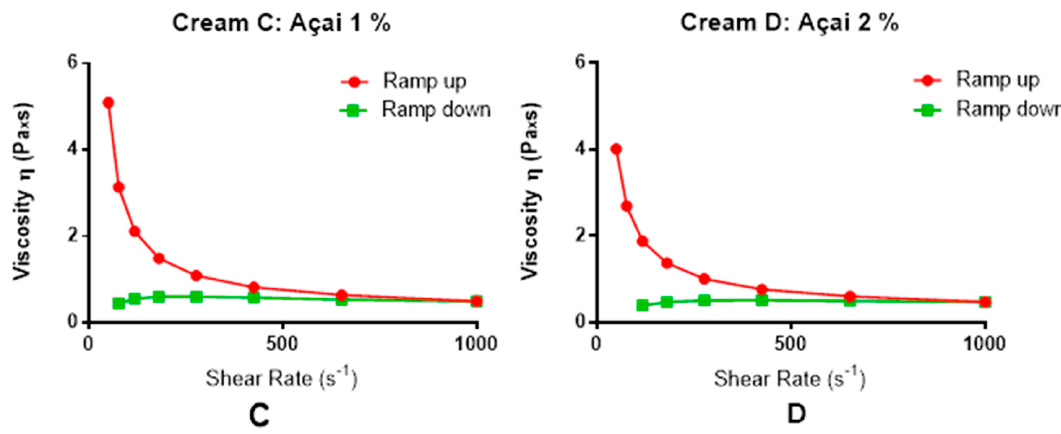
Figure 3. Results of thixotropic loop experiments for cream formulations at increasing açai extract. ( A ) Cream with 0% açai extract; ( B ) cream with 0.5% açai extract; ( C ) ream with 1% açai extract; ( D ) cream with 2% açai extract.